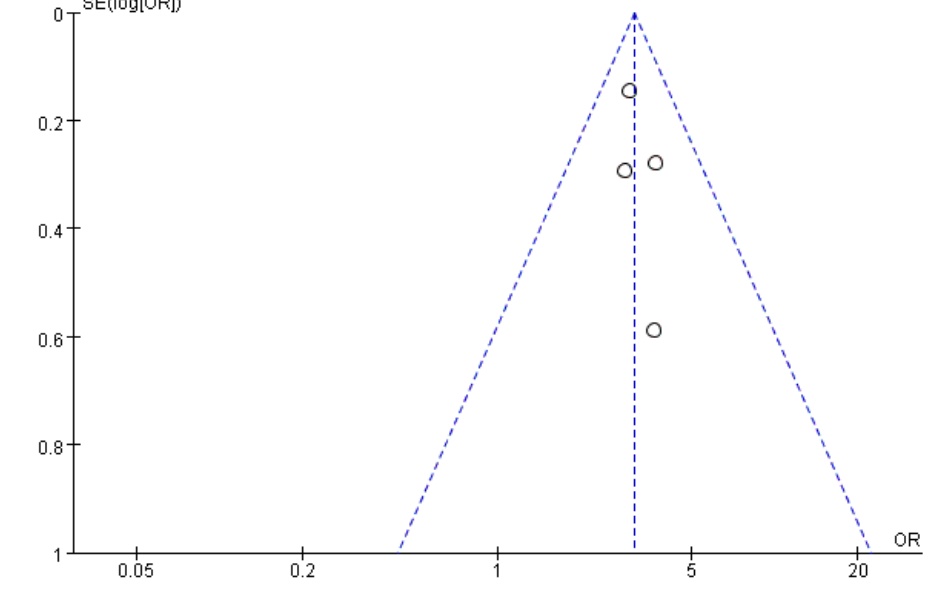
Figure 11. The funnel plot of publication bias for age <6 years for flatfoot in children.